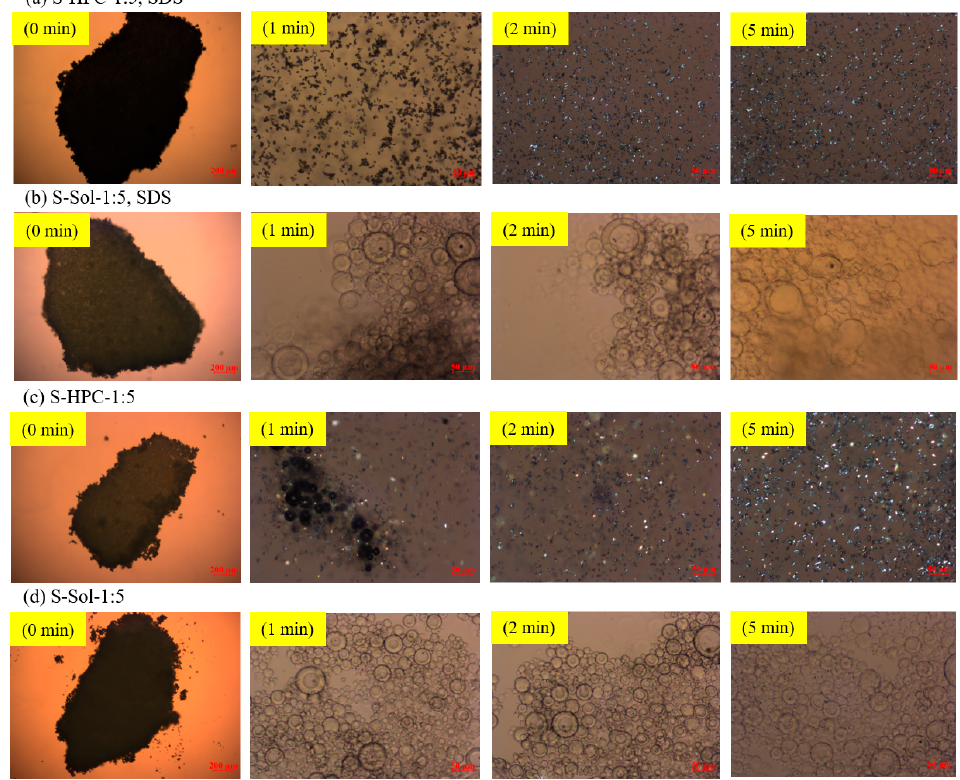
Figure 8. PLM images of a loose compact of the spray-dried particles with a 1:5 drug:polymer mass ratio in 20 µL deionized water: ( a ) HPC with SDS, ( b ) Sol with SDS, ( c ) HPC without SDS, and ( d ) Sol without SDS. The images were taken at 0 (before adding water), 1, 2, and 5 min after the addition of deionized water. Except for the 0 min image (5× magnification, scale bar: 200 µm), which focused on the compact, all other images focused on particles that emanated from the surface of the compact, which were captured at 20× magnification (scale bar: 50 µm).